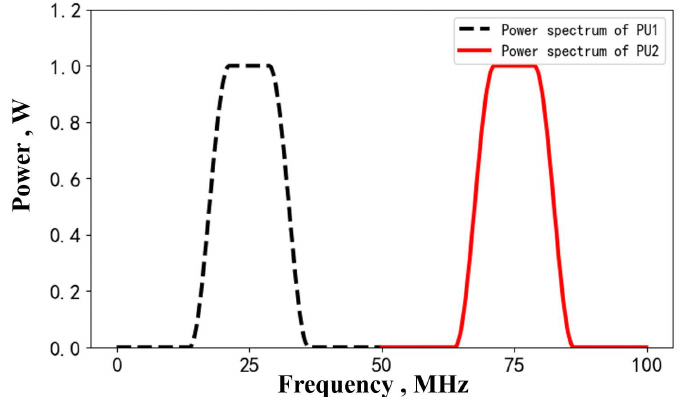
Figure 7. The power spectrum of PU1 and PU2 in the testing data set.